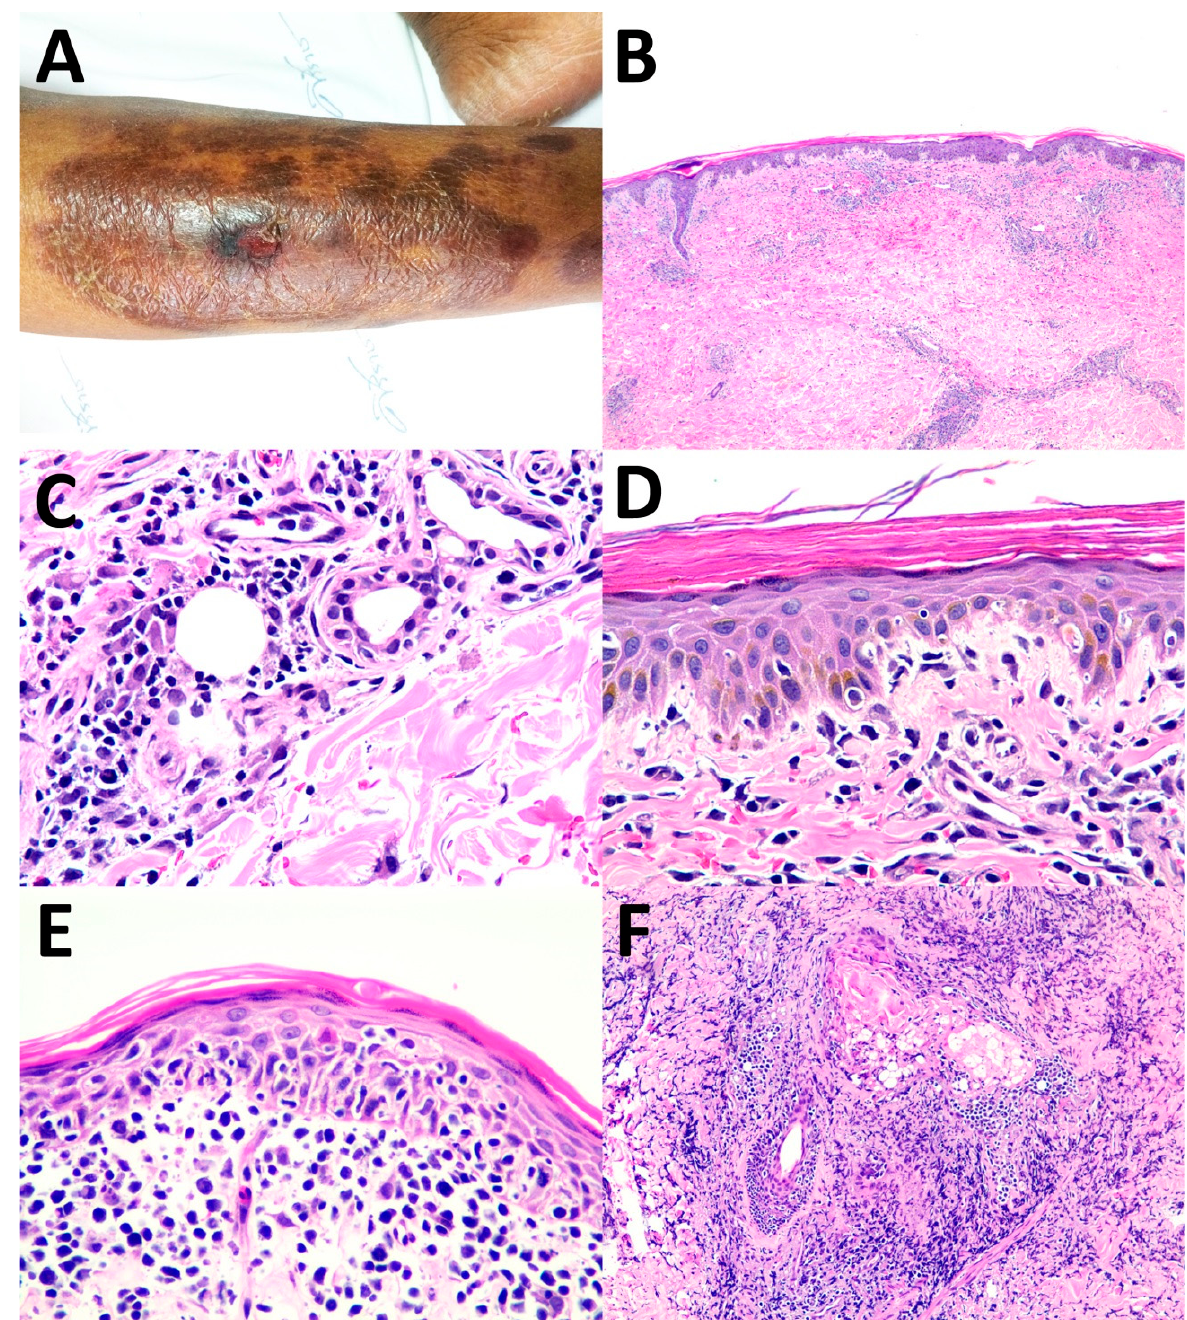
Figure 3. Interface dermatitis pattern: ( A ) multiple purplish plaques on right leg; ( B ) superficial and deep perivascular infiltration by small lymphocytes with overlying epidermal hyperkeratosis (H&E, original magnification ×100); ( C ) perieccrine infiltration by atypical small-to-medium lymphocytes (H&E, original magnification ×400); ( D ) basal vacuolar change and few necrotic keratinocytes (H&E, original magnification ×400); ( E ) presence of epidermotropism; ( F ) presence of folliculotropism (H&E, original magnification ×400).